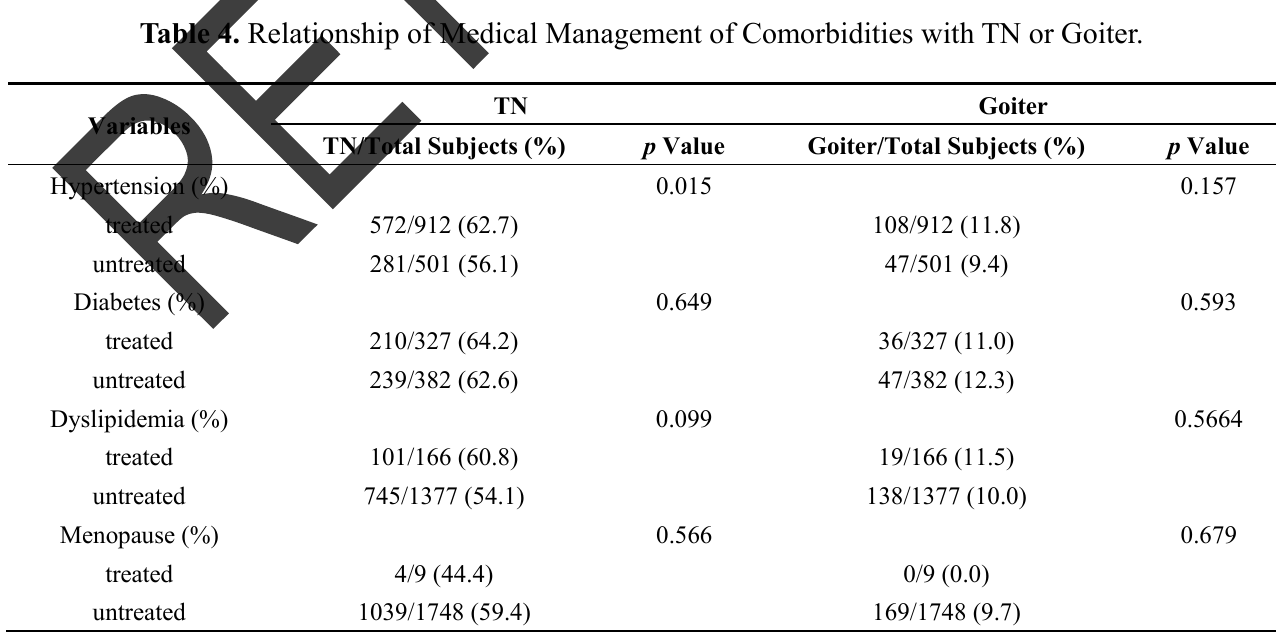
Table 4. Relationship of Medical Management of Comorbidities with TN or